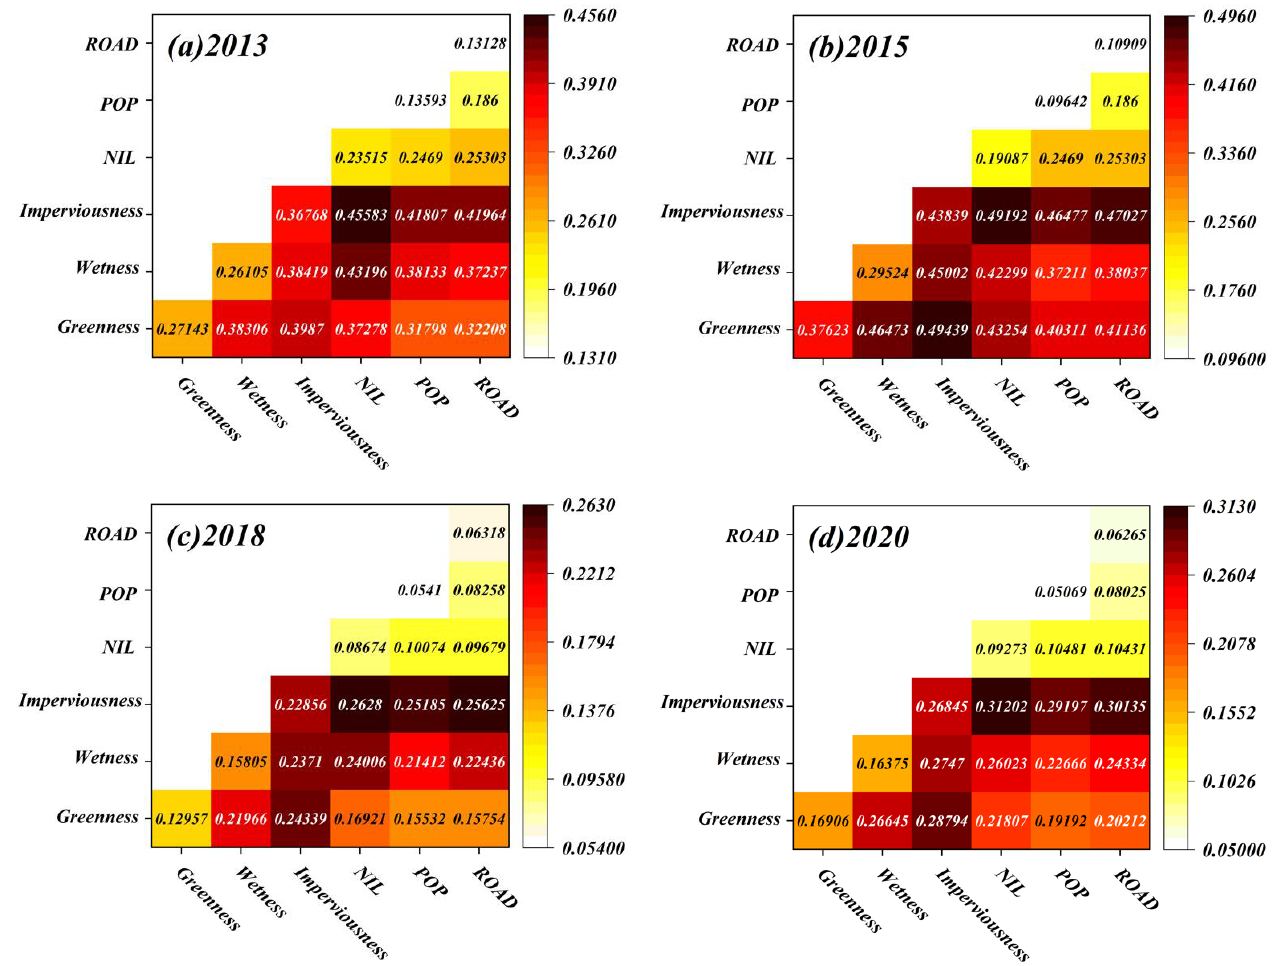
Figure 10. Interaction of multiple factors. ( a – d ) represent the multi-factor interaction superposition results for 2013, 2015, 2018, 2020, respectively. results for 2013, 2015, 2018, 2020,